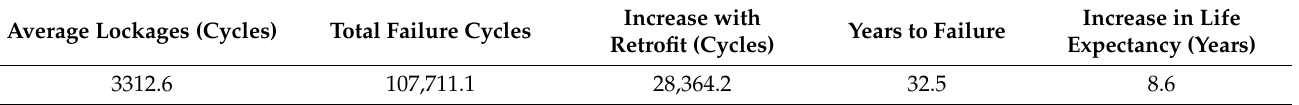
Table 4. Stresses from the gate model of the Greenup Lock and Dam gate 1 (35.2 kip pre-stress).